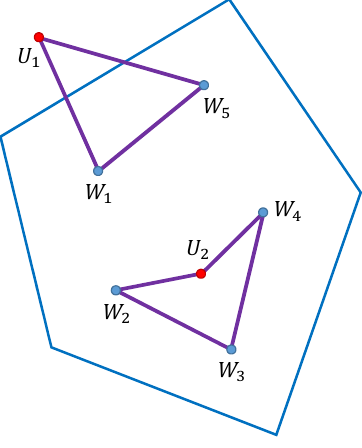
Figure 4. Routes of UAVs in the operation.